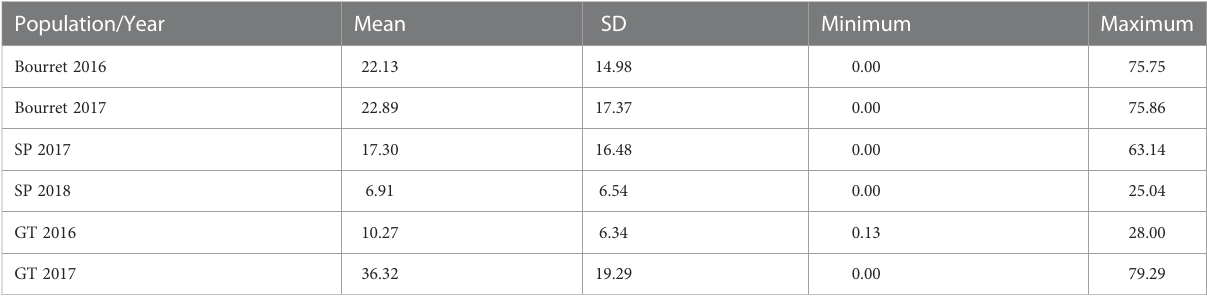
TABLE 2 Mean, standard deviation (SD), minimum and maximum values of emerged broomrape shoots in a set of 104 sun fl ower accessions evaluated for broomrape populations Bourret, SP and GT in two years.